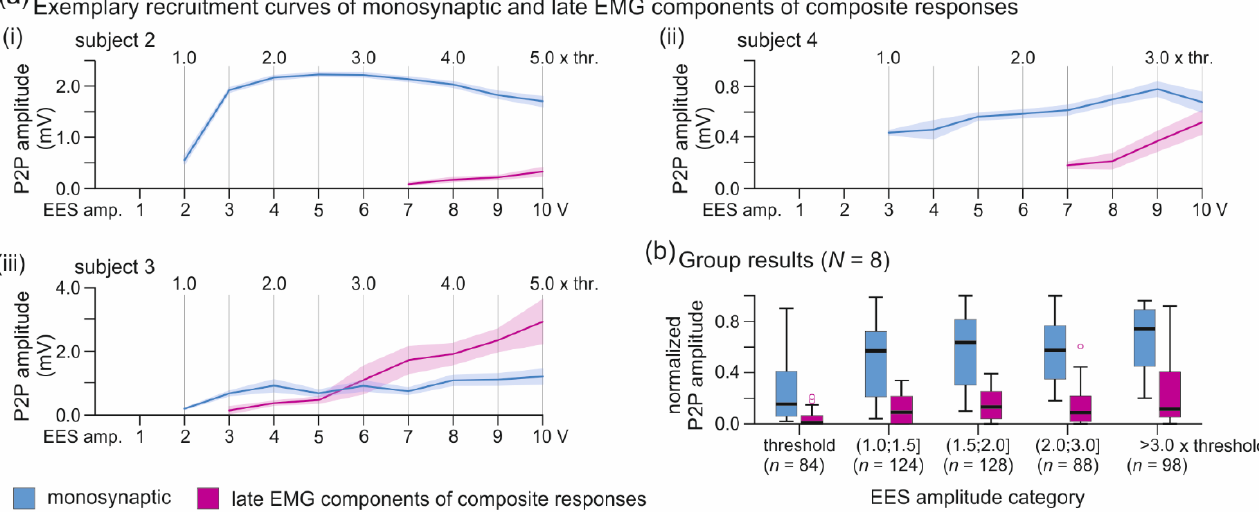
Figure 7. Recruitment curves of monosynaptic and late EMG components of composite TA responses with graded EES. ( a ) Individual recruitment curves of composite responses with increasing contributions of late EMG components. Data derived from ( i ) subject 2, recording 1, electrode setup 0 − c+; ( ii ) subject 4, recording 5, 3 − c+; ( iii ) subject 3, recording 1, 3 − c+. ( b ) Group results of the recruitment of the monosynaptic and late EMG components considering cases with four or more EES amplitude levels tested. Boxplots show distributions of normalized peak-to-peak amplitudes (relative to the maximum TA responses evoked across all tested electrode setups within the same recording) for EES amplitude categories as indicated. Circles illustrate outliers. Numbers in brackets are available data per category. EES, epidural electrical stimulation; P2P, peak-to-peak; TA, tibialis anterior; thr., threshold.